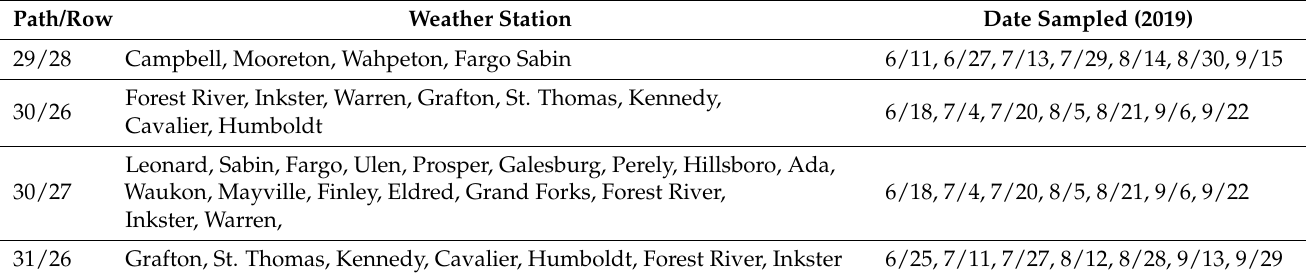
Table 1. List of the Landsat 8 image (path/row) acquired over the study area covering weather stations in